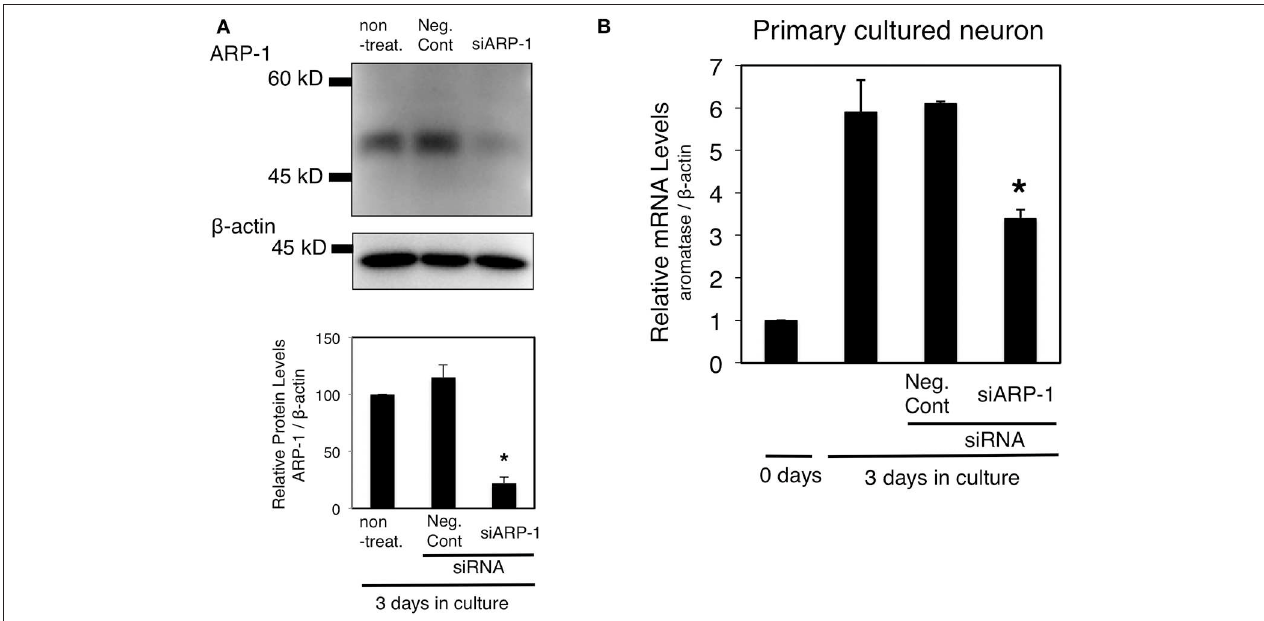
FIGURE 5 | Effect of ARP-1-targeting siRNA on expression of the endogenous aromatase gene in primary cultured neural cells. (A) Diencephalic neurons were transfected with ARP-1-targeting siRNA and cultured for 48h, and then the lysates were subjected to western blotting with an anti-ARP-1 antibody and an anti- β -actin antibody (top panel). The amount of ARP-1 protein is quantitated and expressed as the relative ARP-1/ β -actin value (lower panel). The mean ± SEM of three independent experiments is shown in the figure. One-way ANOVA showed a significantly different distribution ( p < 0.0002). The p -value of the Tukey–Kramer test is indicated with the symbol as follows. Asterisks indicate statistically significant differences in ARP-1 protein levels between the ARP-1 siRNA and negative control siRNA groups ( p < 0.05). (B) Effect of ARP-1 knockdown on the aromatase mRNA level in neural cells. Diencephalic neurons were prepared as in (A) , and total RNA was extracted from the cultured cells. The total RNA was analyzed by RT-qPCR to determine the amount of aromatase mRNA as described in the Materials and Methods section. The results are presented as the mean ± SEM of three independent experiments. One-way ANOVA showed a significantly different distribution ( p < 0.0002). The p -value of the Tukey–Kramer test is indicated with the symbol as follows. Asterisks indicate statistically significant differences in aromatase mRNA levels between the ARP-1 siRNA and the negative control siRNA groups ( p <